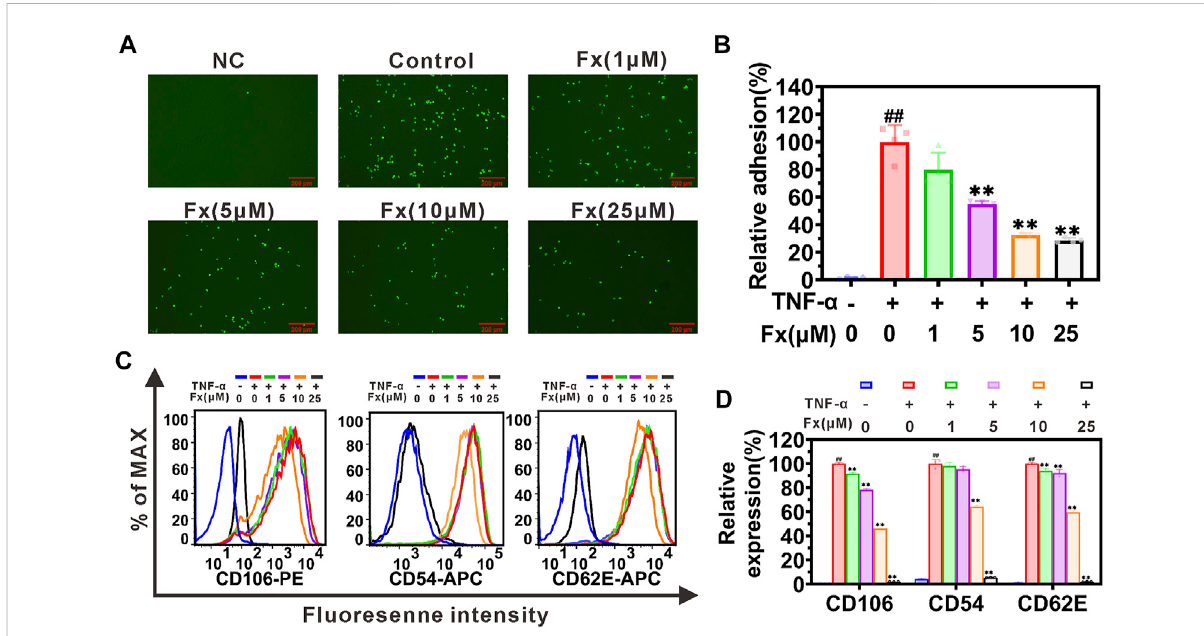
FIGURE 2 Fx interrupts MCF-7 cells adhesion to HUVECs by suppressing CAMs expression. (A) MCF-7 cells (green, labeled with Rhodamine 123) adhered to the HUVECs were photographed using a fl uorescence microscope. (B) The relative adhesion of MCF-7 cells to HUVECs was expressed as percentage of control (TNF- α only). (C) HUVECs were pretreated with Fx for 24 h, followed by incubation with TNF- α (10 ng/ml) for another 4 h. Expression of CD106 (VCAM-1), CD54 (ICAM-1) and CD62E (E-selectin) on HUVECs were analyzed by fl ow cytometry. (D) The relative expression of CD106, CD54 and CD62E was expressed as percentage of the mean fl uorescence intensity of control (TNF- α only). NC, negative control. Data are presented as mean ± SD ( n = 3 – 6); ** indicate p < 0.01 vs . Control (TNF- α only); ## indicate p < 0.01 vs . Negative control (TNF- α